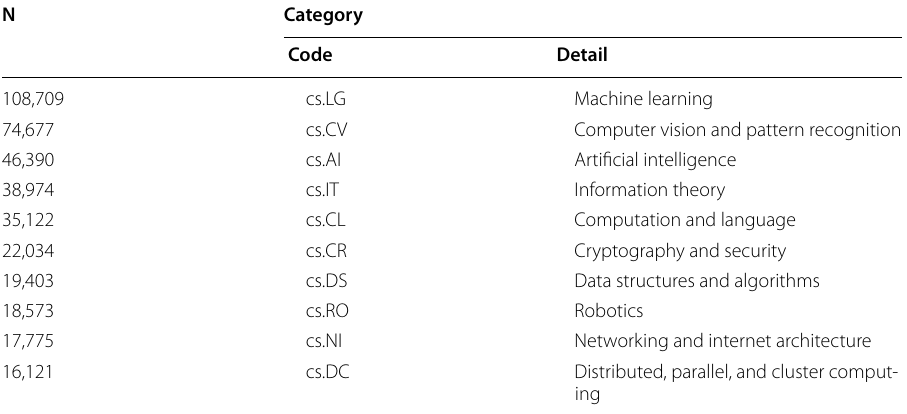
Table 1 The top ten most popular computer science’s sub-categories ranked by the numbers of arXiv’s search results (the first column) from highest to lowest